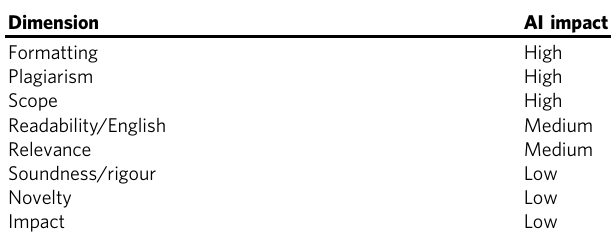
Table 5 Potential role of AI in the different dimensions of the peer review